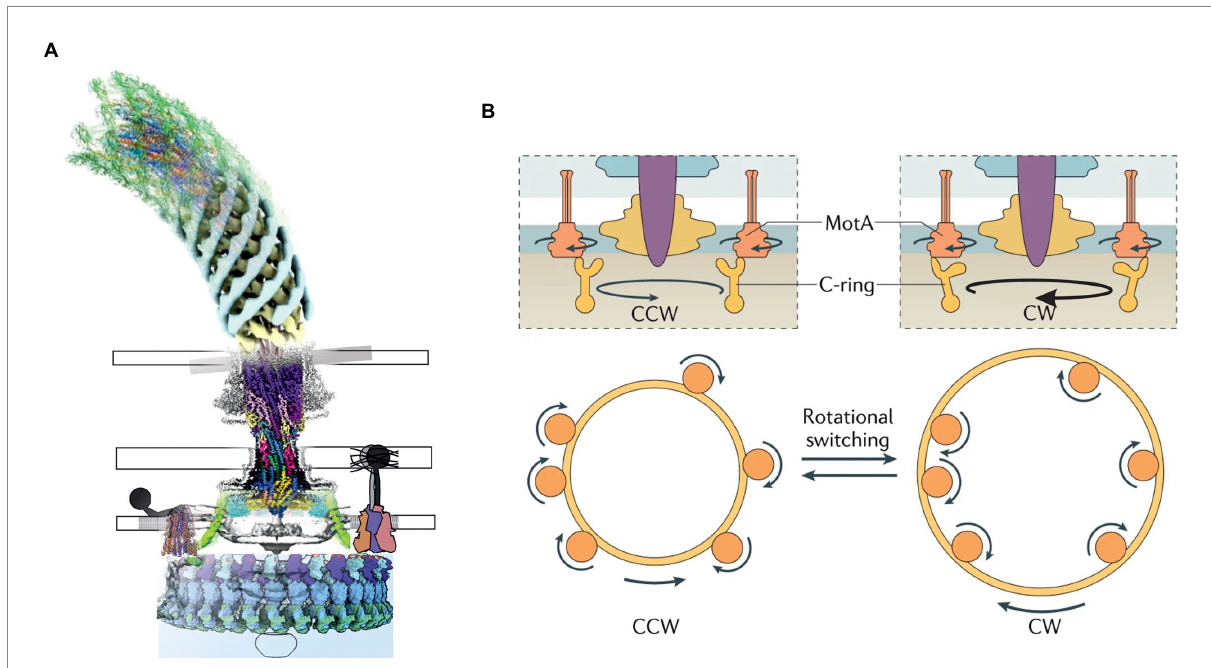
FIGURE 1 (A) A composite model of the bacterial flagellar motor based on the published structures. (B) The current model of rotation and switching of the BFM driven by the unidirectional rotation of MotAB. ( B adapted from: